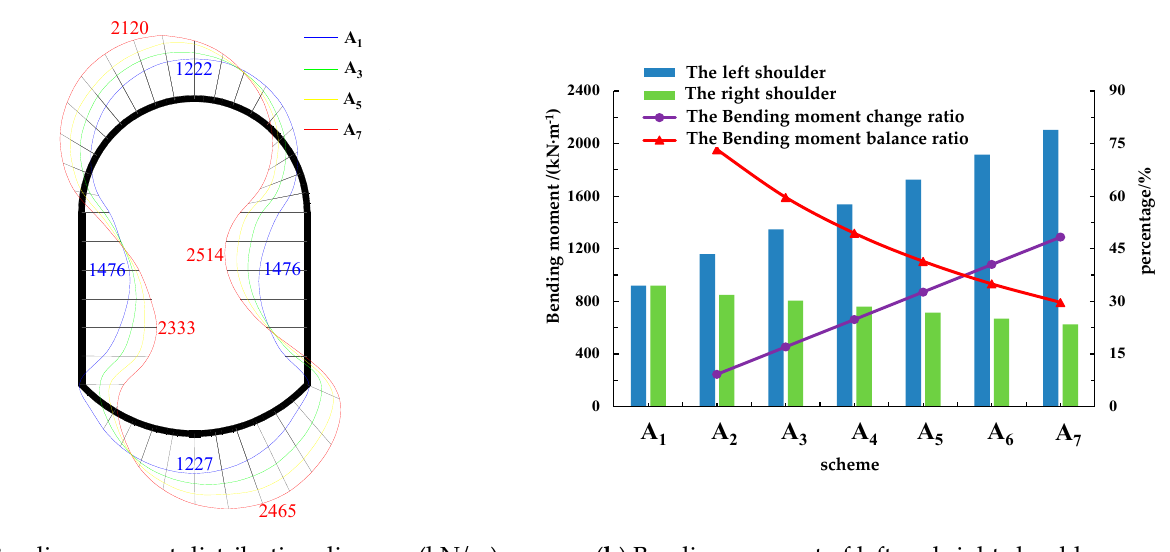
Figure 5. Bending moment analysis with different asymmetric coefficients. ( a ) Bending moment distribution diagram ( b ) Bending moment of left and right shoulder.